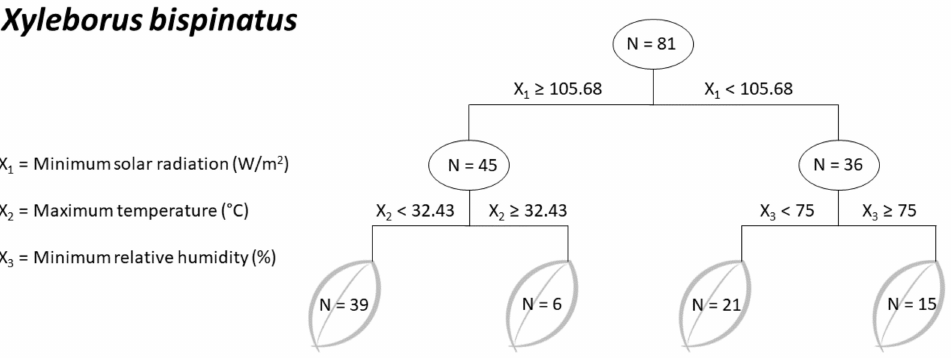
Figure 9. Decision tree schematic for Xyleborus bispinatus abundance using weather conditions as explanatory